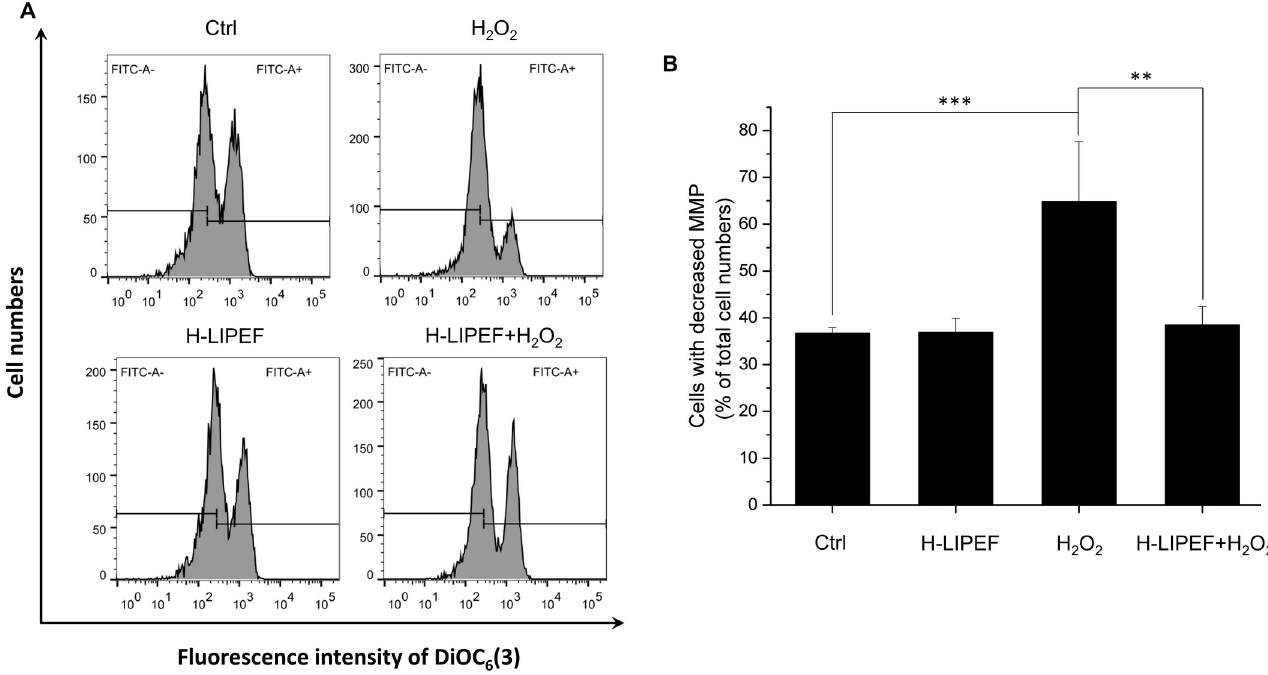
Fig 7. Effect of H-LIPEF on H 2 O 2 -induced MMP reduction in SH-SY5Y cells. (A) MMP was analyzed by flow cytometry with DiOC 6 (3) fluorescent dye. (B) Quantification of the cells with decreased MMP after H-LIPEF, H 2 O 2 , or H-LIPEF+H 2 O 2 treatment. Data represent the mean ± standard deviation (n = 3). Comparisons of the effect of H 2 O 2 and H-LIPEF on the MMP were analyzed using two-way ANOVA with Tukey’s post hoc test ( ��� P < 0.001 and �� P < 0.01).